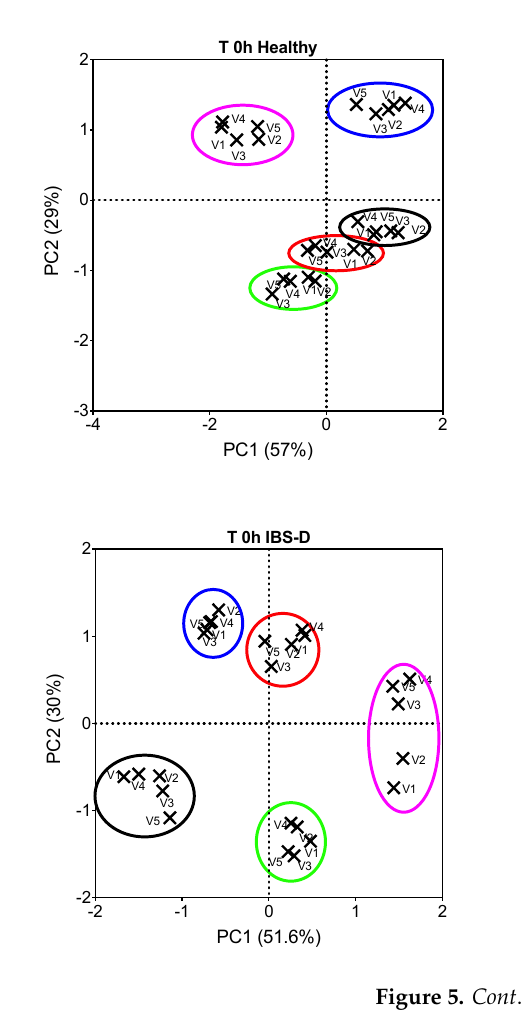
Figure 5. Score plot of the principal component analysis representing the variation in bacterial composition at 0 and 24 h post-inoculation with fresh faecal material collected from ( A ), healthy donors (n = 5); ( B ), diarrhoea-predominant IBS (IBS-D, n = 5) and ( C ), constipation-predominant IBS (IBS-C, n = 5) donors. The five independent donors are colour coded (red, blue, green, pink and black clusters) and the different experimental conditions are labelled as V1 (Control, only gut model medium), V2 (B-GOS), V3 (ferritin), V4 (FeSO 4 ) and V5 (IHAT). The percentage variance values accounted for by the two first components (PC1 and PC2) are shown in parenthesis.